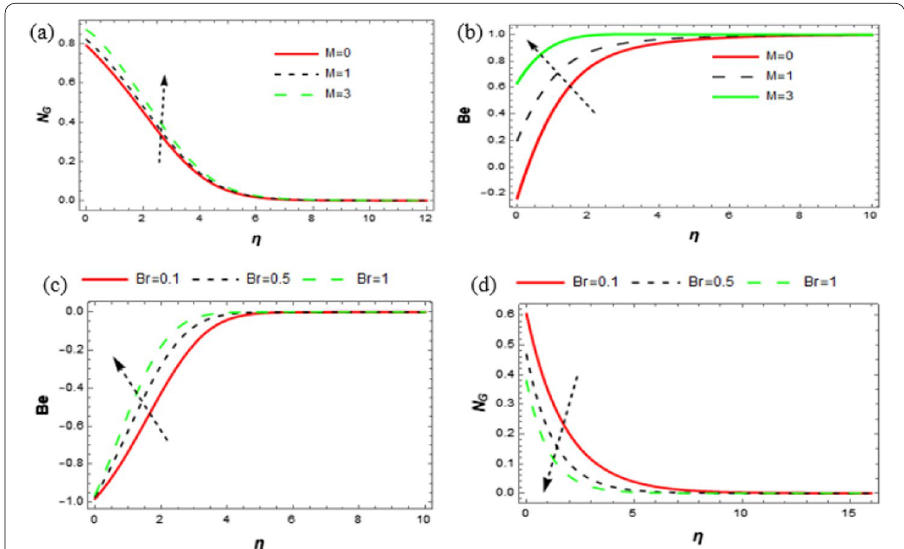
Fig. 8 a , b , c , and d Effect of magnetic field parameter ( M ), Brinkman number, on entropy generation, and Bejan number